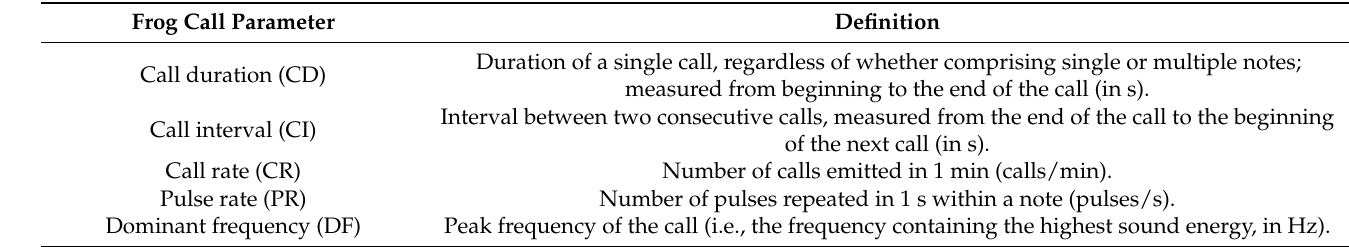
Figure 2. Oscillogram ( A ), spectrogram ( B ), and power spectrum ( C ) of a 1.2 s call of M. fissipes , and oscillogram ( D ), spectrogram ( E ), and power spectrum ( F ) of a 0.6 s call of F. multistriata . Table 1. Description of frog advertisement call parameters used in the current